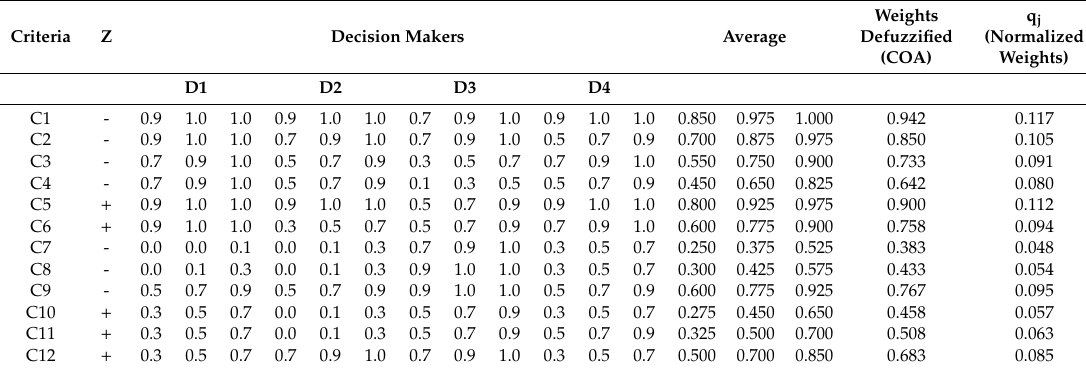
Table 7. Calculation of criteria weights using the center of area